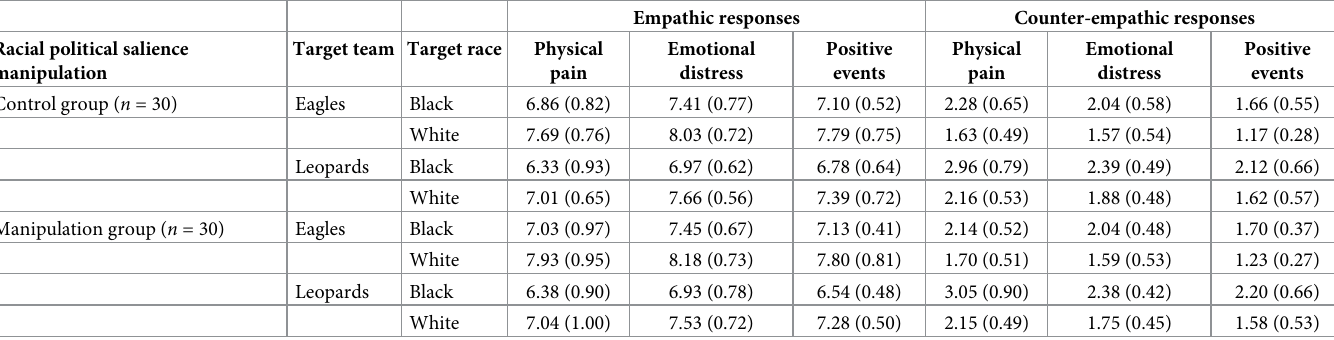
Table 1. Self-reported empathy and counter-empathic responses.